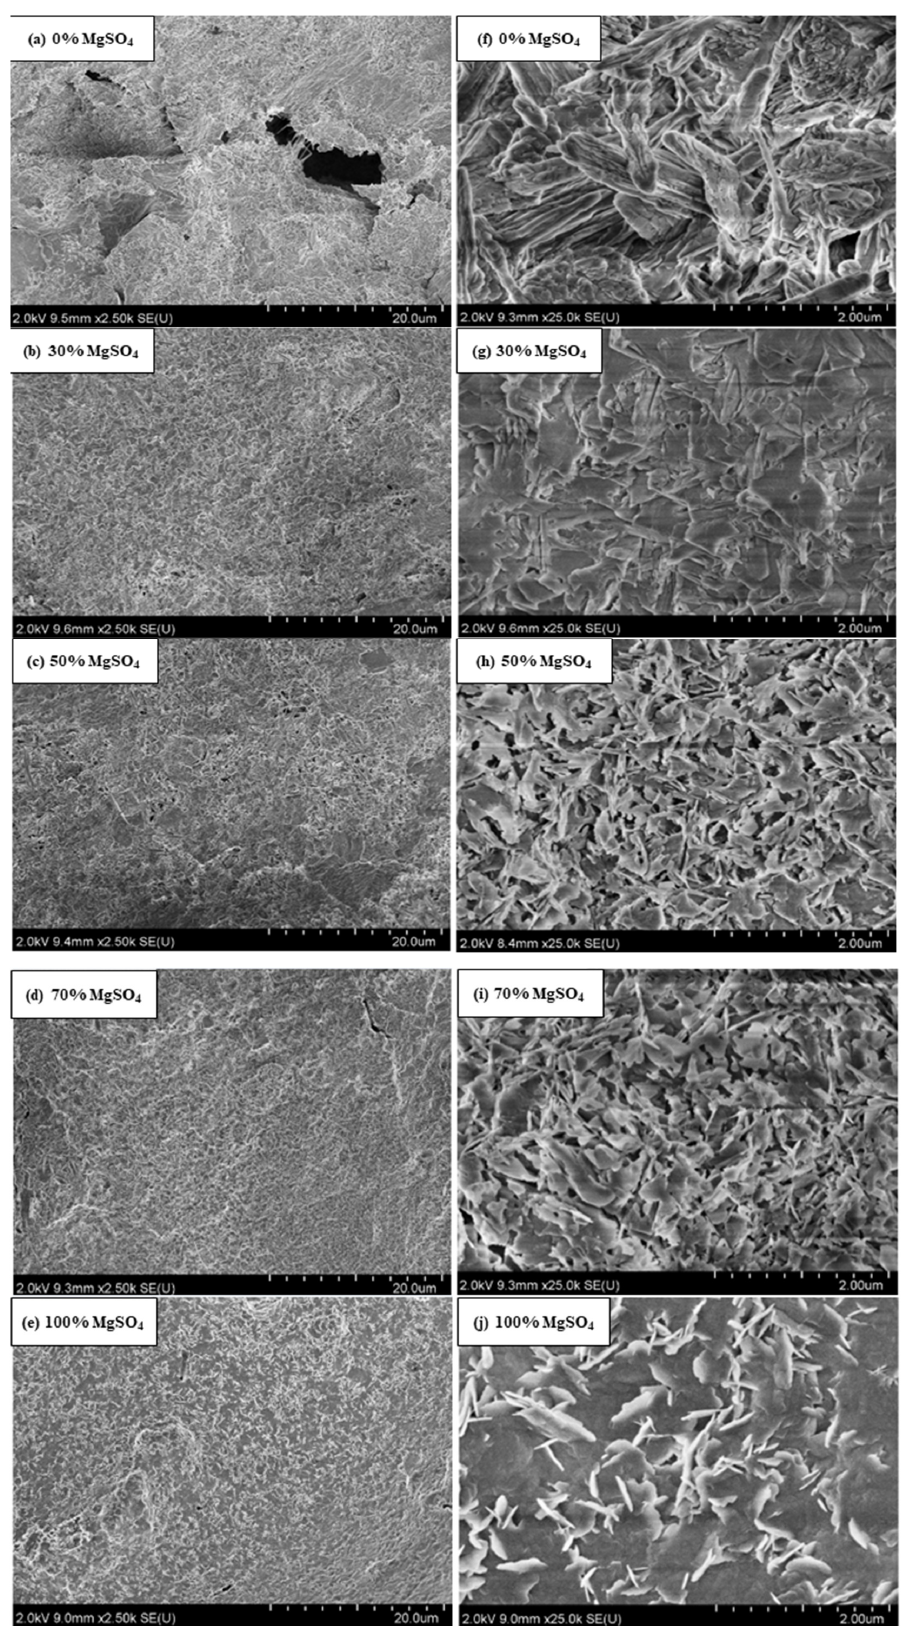
Figure 8. The SEM images of cement with different mass fractions of MgSO 4 after water immersion for 28 days.